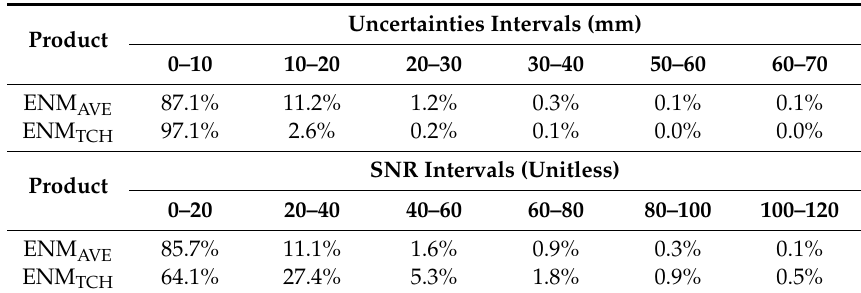
Table 2. Distribution of uncertainties and SNRs for the simple ensemble average (ENM AVE ) and Three-Cornered-Hat (TCH)-weighted ensembles (ENM TCH ). The percent shows the percentage of cells lying between (Lower Boundary–Upper Boundary) for each product.